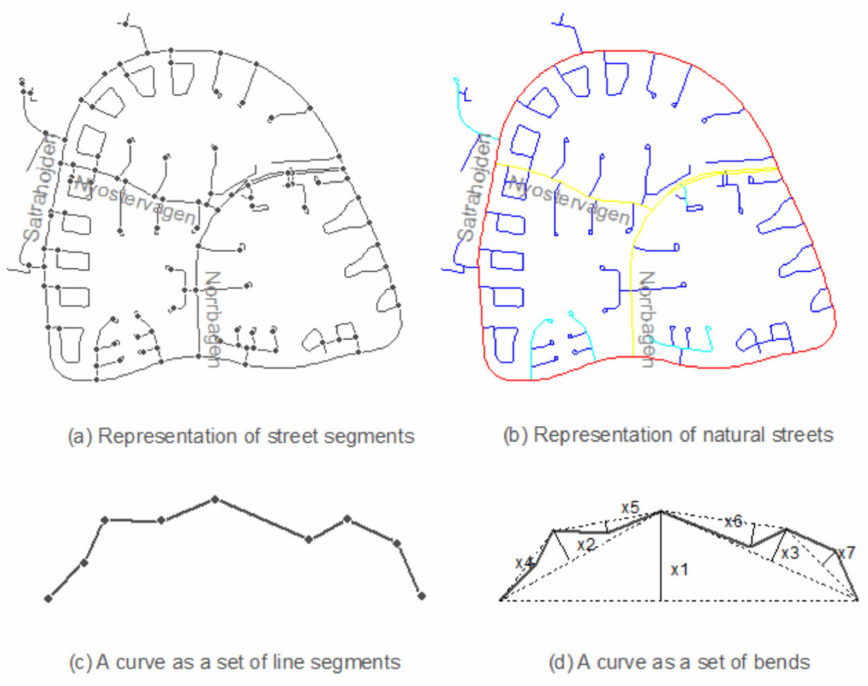
Figure 1. (Color online) Geometric primitives versus geometrically meaningful entities. (Note: A street networkisrepresentedasasetofjunctionsorstreetsegments(geometricprimitives, whicharenotcenters) ( a ), whereas it is more correctly perceived as a collection of named streets (geometrically meaningful entities, which are centers) ( b ), each of which is colored as one of the four hierarchical levels: blue for the least connected streets, red for the most connected street (only one), and yellow and turquoise for those between the most and the least connected. A curvilinear feature is usually represented as a set of line segments (geometric primitives, which are not centers) ( c ), but it is more correctly perceived as a collection of far more small bends than large ones (geometrically meaningful entities, which are centers) ( d ), because the notion of far more small bends than large ones occurs twice: (1) x 1 + x 2 + x 3 > x 4 + x 5 + x 6 + x 7 , and (2) x 1 > x 2 + x 3